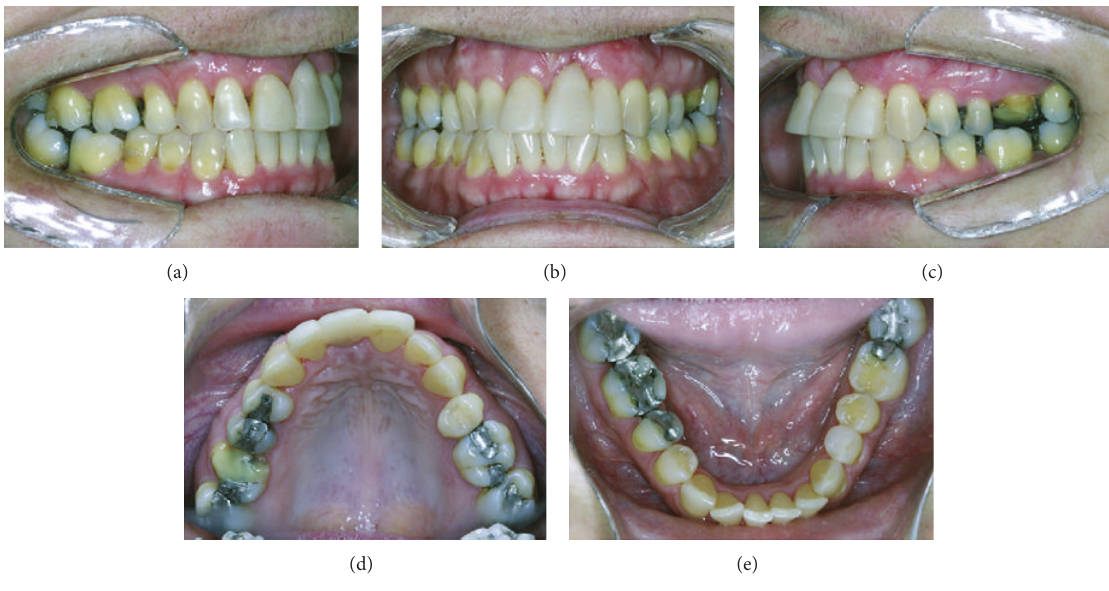
Figure 4: Pretreatment intraoral